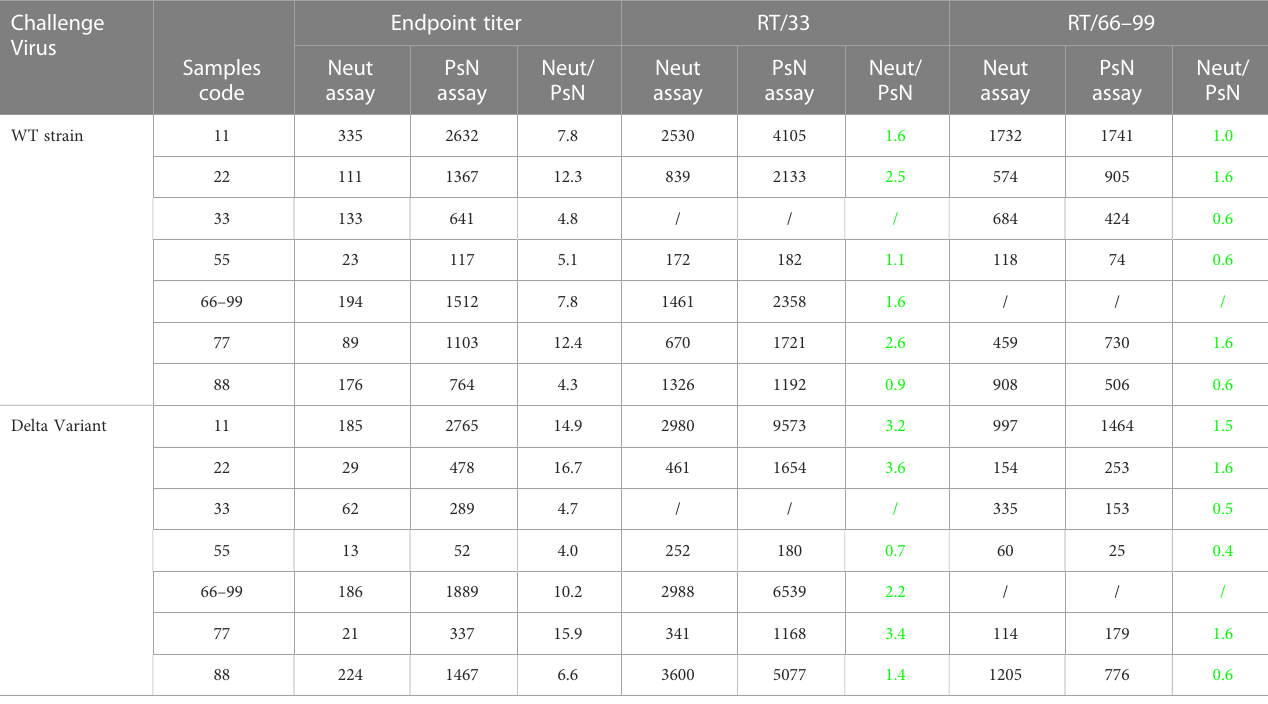
pseudovirus neutralization assay; Neut, live virus neutralization